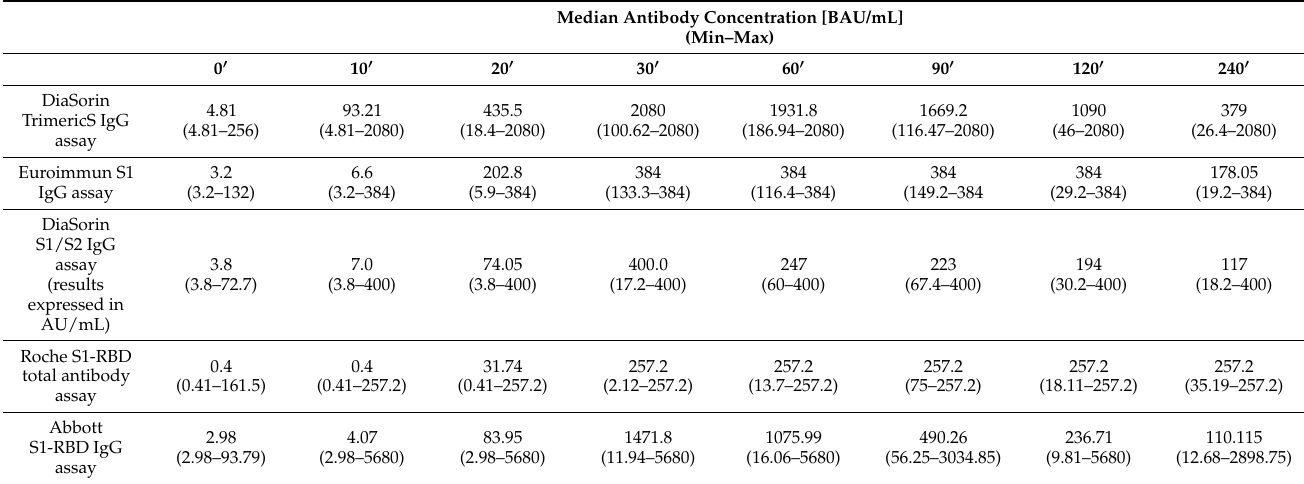
Table 2. Anti-SARS-CoV-2 antibody serum concentrations in 100 vaccinees measured by 5 immunoassays at 8 timepoints over 8 months following the first vaccine dose administration.